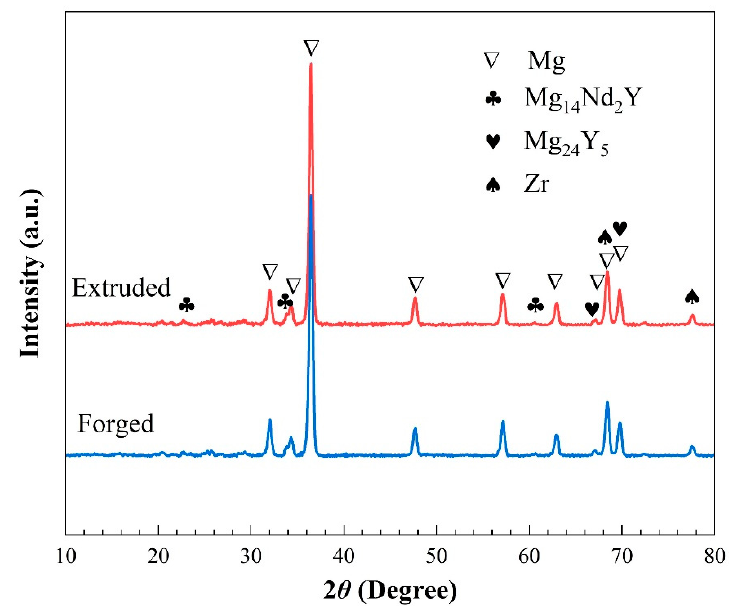
Figure 1. XRD patterns of experimental WE43 alloys.